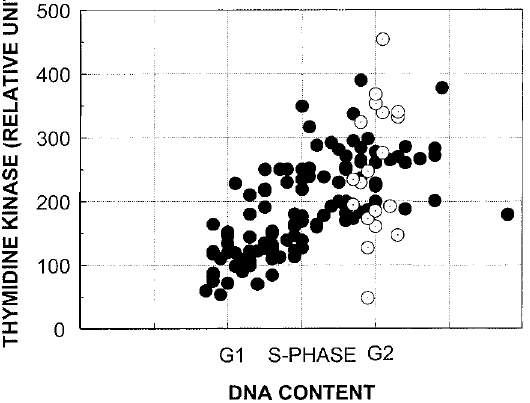
Fig. 4. The relationship between fluorescence intensity of TK1 pos- itive cells (Texas Red) and DNA content (DAPI) in 152 PC-3 cells. Mitotic cells are indicated by open